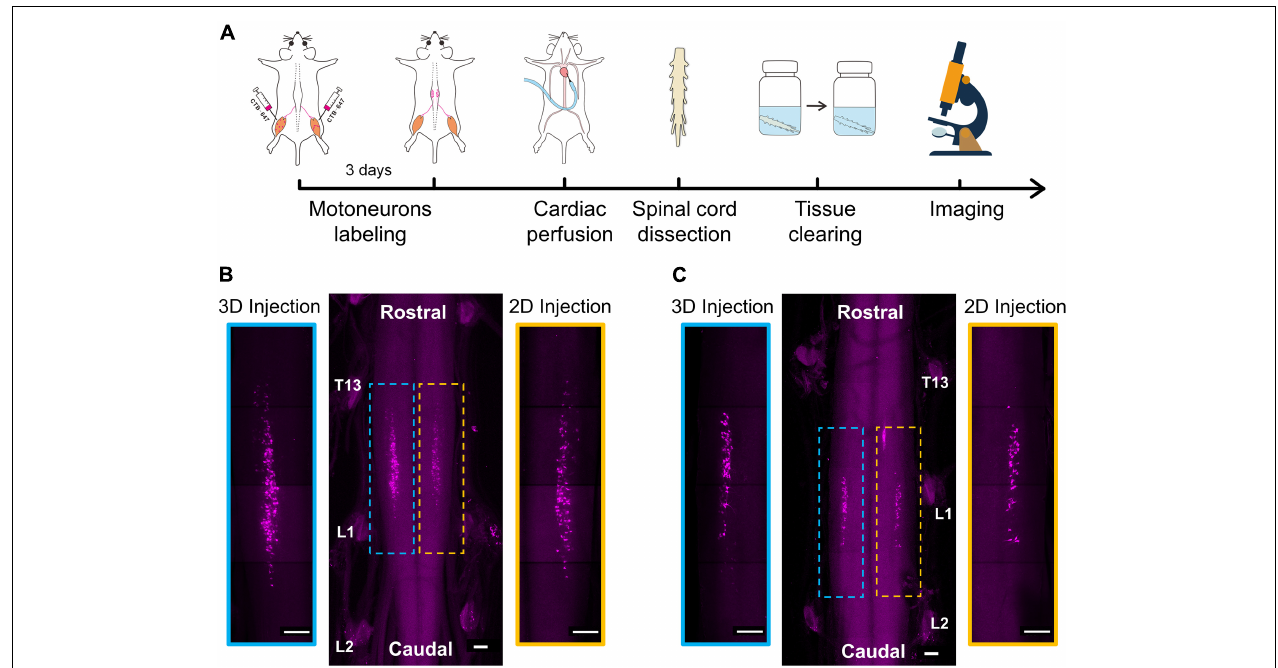
FIGURE 4 | 3D imaging of spinal motor neurons innervating the muscles after intramuscular injection. (A) The entire experimental process of 3D imaging for the spinal cord. (B) Maximum intensity projection (MIP) of the image stacks of labeled motor neurons corresponding to the gastrocnemius. The enlarged images indicated by blue and yellow dotted boxes showed the distribution of motor neurons labeled by the 3D and 2D injections, respectively. (C) MIP images of labeled motor neurons corresponding to the tibialis anterior after the 3D and 2D injections, respectively. Scale bar: 300 µ